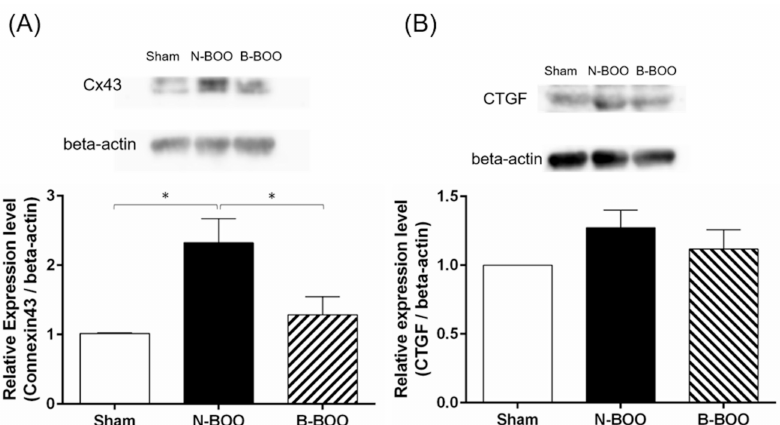
Figure 4. Representative Western blots of ( A ) Cx43 expression, and ( B ) connective tissue growth factor (CTGF) expression in the bladder (upper). Relative expression levels of ( A ) Cx43 / beta-actin; ( B ) CTGF / beta-actin in the bladder (lower). A single asterisk indicates p <